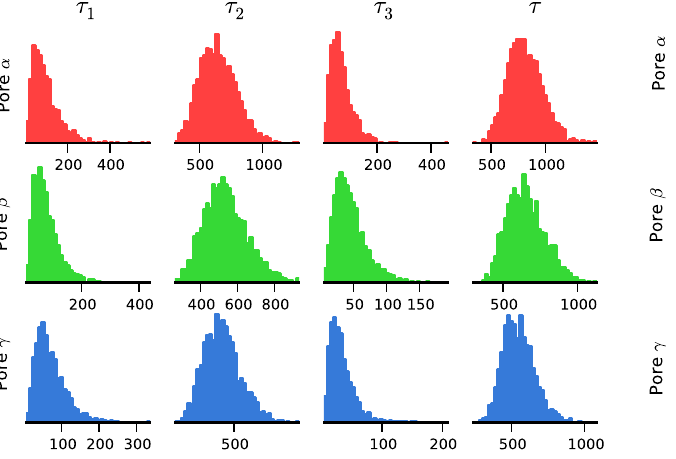
FIG. 8. Comparison of the filling, transfer, escape, and translocation time distributions for the three pores at F ¼ 0 : 5 and (cid:1) ¼ 2 : 0